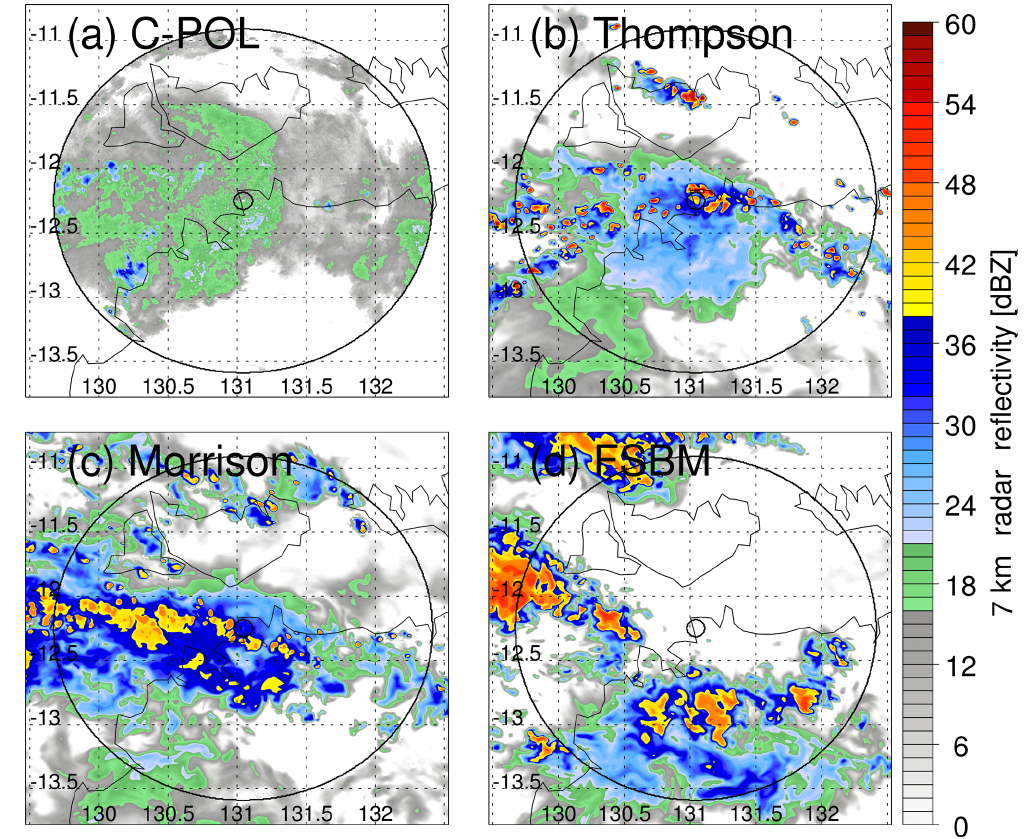
Figure 4. As in Fig. 3, but for 7km